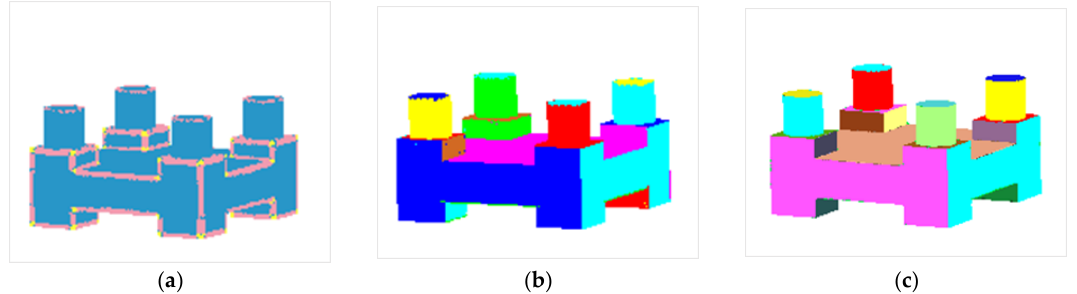
Figure 12. Experimental results of the support frame model: ( a ) feature point segmentation; ( b ) feature surface extraction; ( c ) feature surface reconstruction.